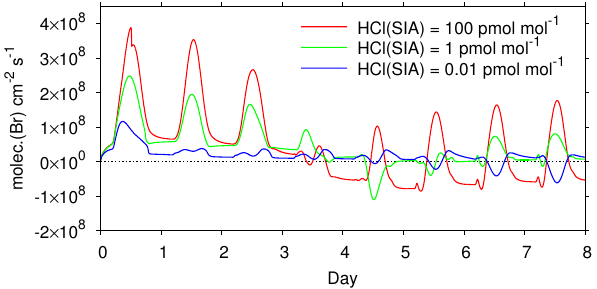
Fig. 13. Net vertical fluxes of inorganic bromine gases at the in- terface between the snowpack and the atmosphere as simulated in the same model runs presented in Fig. 12a–c, i.e., using the fixed mixing ratios of HCl in the SIA at 100pmolmol − 1 (red line), 1pmolmol − 1 (green line), and 0.01pmolmol − 1 (blue line), while in the ambient air they are fixed at 100pmolmol − 1 for all the